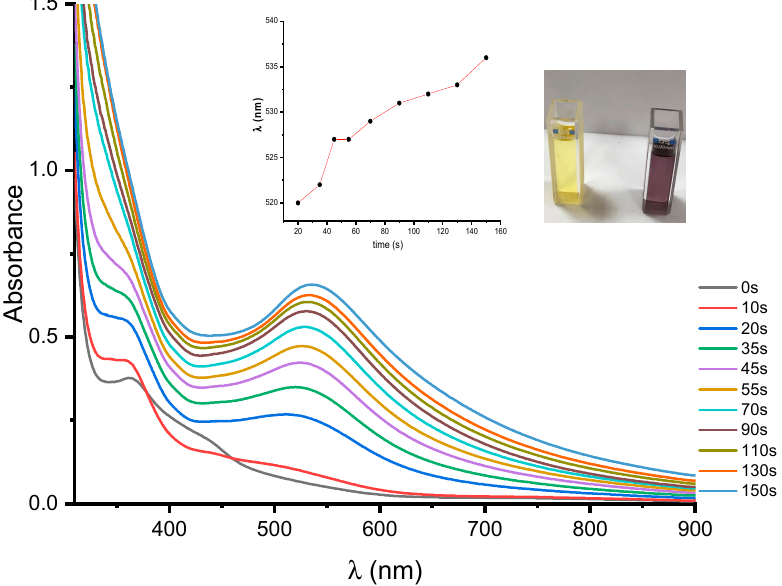
Figure 5. Evolution of the absorption spectra of irradiated mixtures ( λ irr = 419 nm). Solution: HLCuCl 0.05 wt% gold chloride 4wt%, TEA 1wt%, and iodonium salt 1 wt% dissolved in 25 mL of DMF.